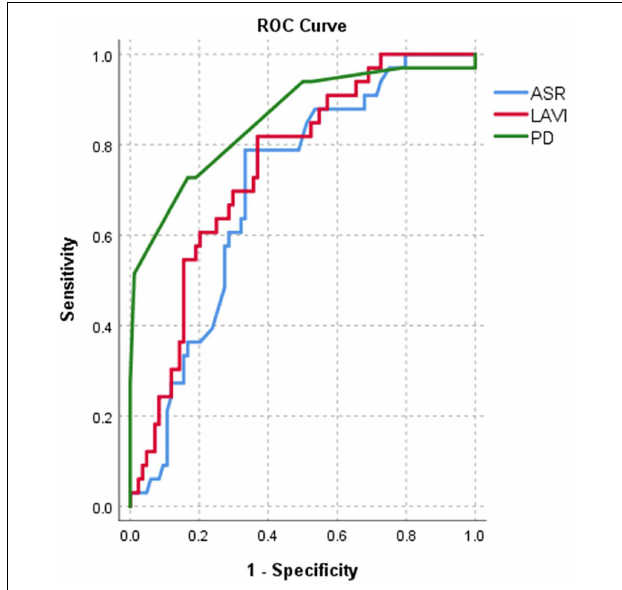
FIGURE 1 | Area under curve (AUC)-based C -statistics for new-onset AF: for Pd (AUC = 0.86), LAVi (AUC = 0.76), and ASr (AUC = 0.7) in the whole